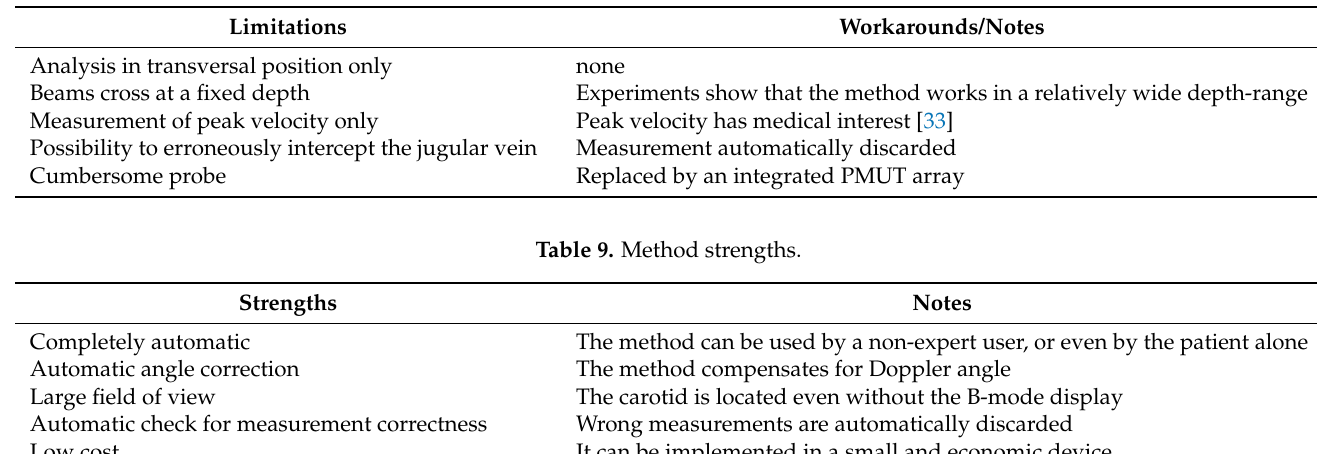
Table 8. Method limitations.